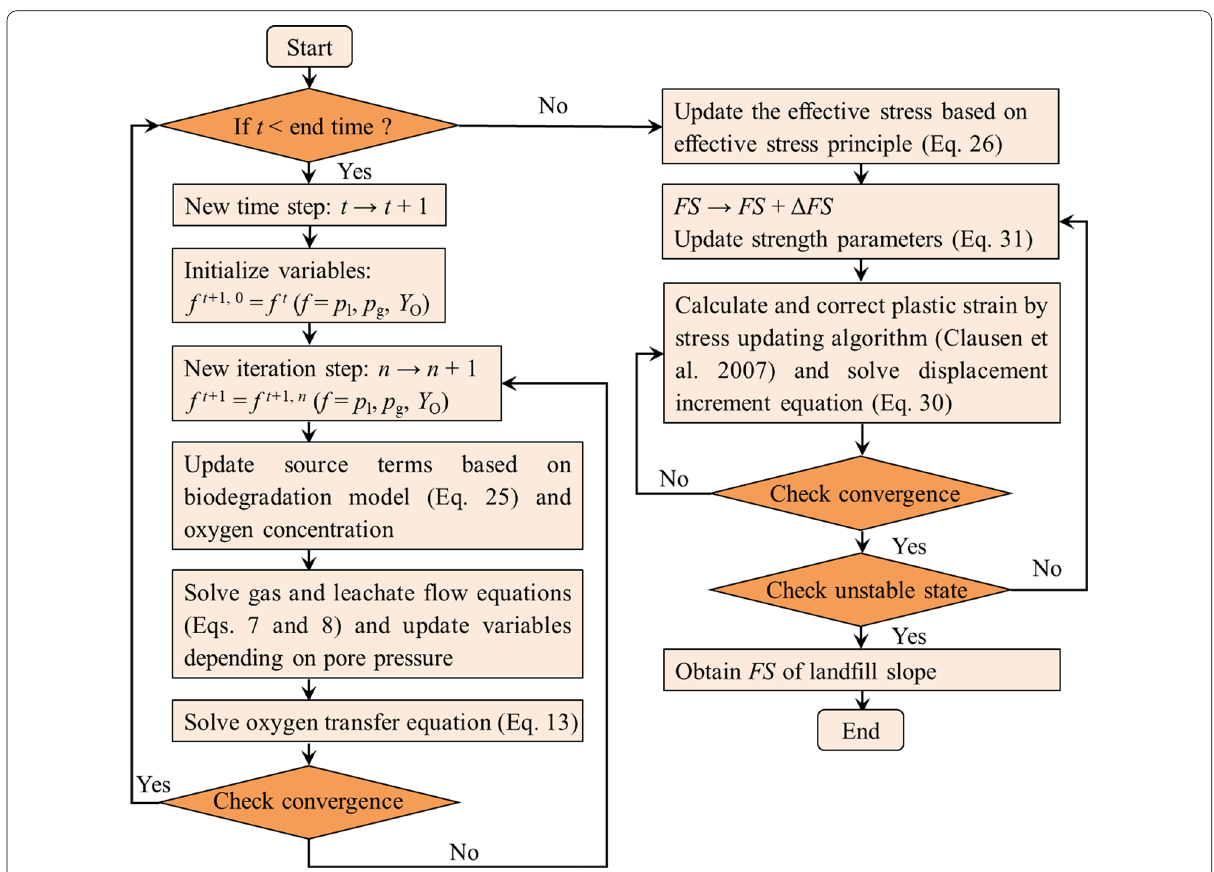
Fig. 1 Solution procedures of the proposed